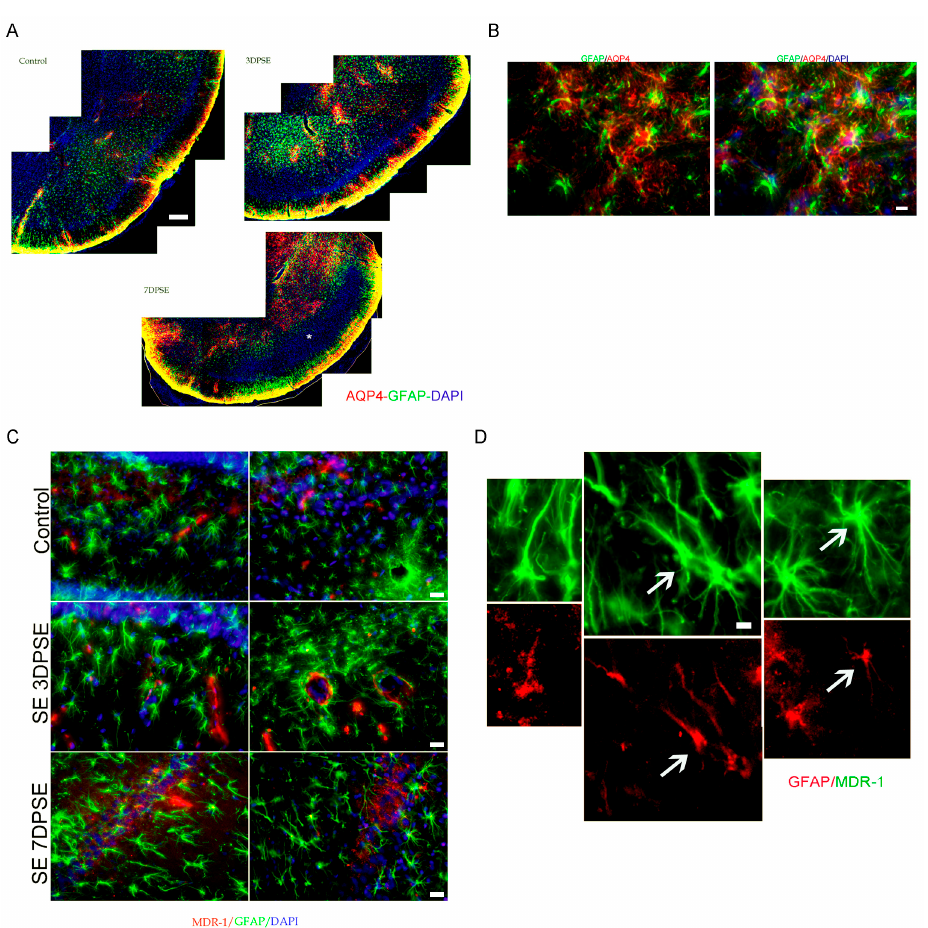
Figure 3. Altered expression of blood vessels permeability after SE. ( A ) Representative images of the alteration in AQP4 expression (red) in the piriform cortex of 3DPSE and 7DPSE where GFAP+ astrocytes (green) were also reduced (asterisk) and yellow represents GFAP/AQP4 overlapping. Scale bar: 500 µ m. ( B ) High magnification details of AQP4 relocalization in astrocytes from the end-feet to the astroglial soma at 7DPSE in the piriform cortex. Scale bar: 15 μ m ( C ) Pgp-170 (MDR-1) expression is induced in blood vessels endothelium and astrocytes from hippocampus at 3 and 7DPSE. Scale bar: 20 µ m. ( D ) High magnification image showing the coexpression of GFAP (green) and Pgp-170 (MDR-1) (red) in the hippocampus at 7DPSE (arrows). Scale bar: 8 μ m.